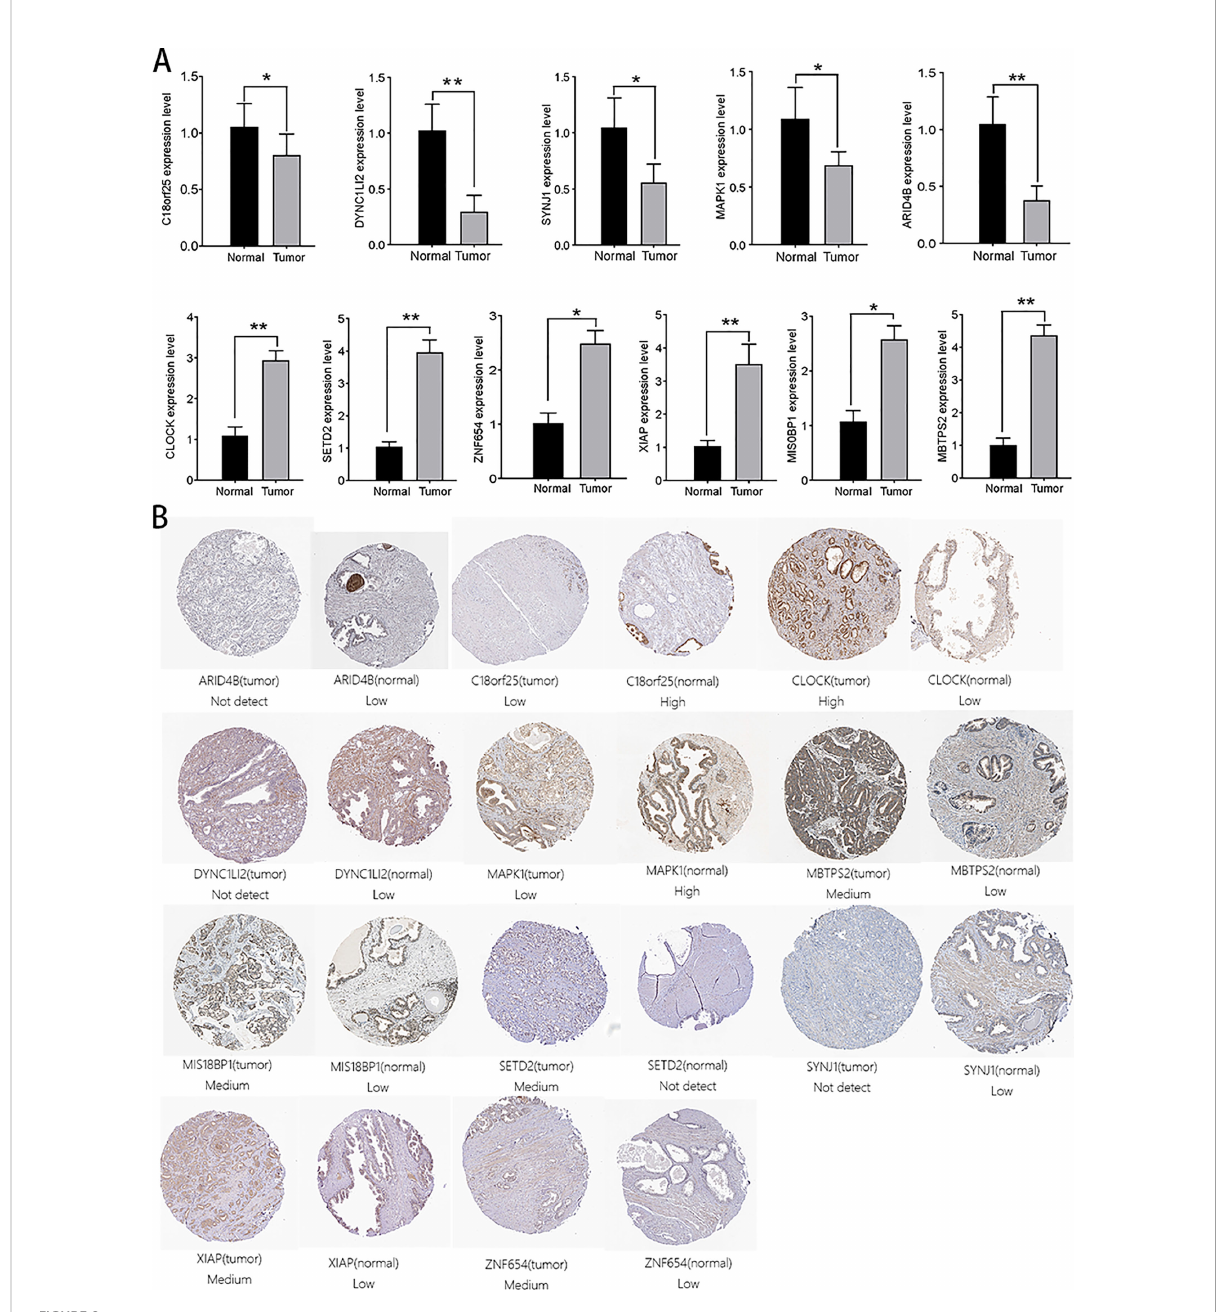
FIGURE 9 Veri fi cation of the expression of aerobic glycolysis-related signatures in normal and tumor tissues. (A) Immunohistochemistry of aerobic glycolysis-related signatures in normal prostate tissue and prostate cancer tissue. (B) rt-PCR veri fi ed the expression of aerobic glycolysis-related signatures in 20 pairs of prostate cancer clinical samples. All data are displayed as means ± SD; mean values for the normal group were normalized to 1.0; two-sided unpaired Student ’ s test was applied. **P < 0.01 and *P < 0.05 vs . normal